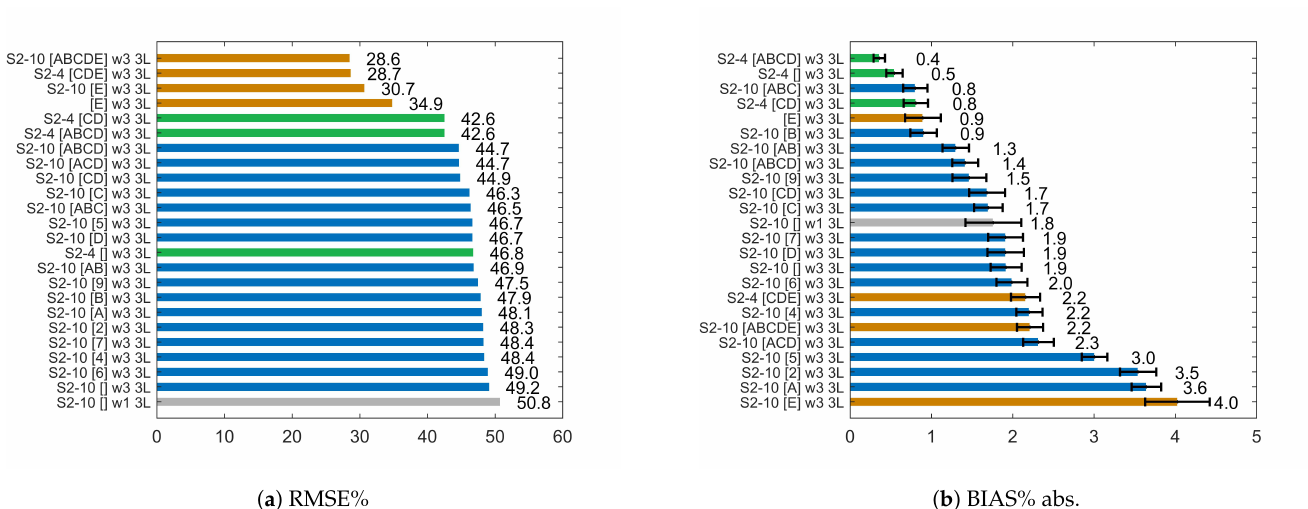
Figure 3. Test set relative root-mean-square error (RMSE%) and average of relative bias absolute values (BIAS% abs.) for DNN models predicting total stem volume with different input feature combinations. The results are mean values from 100 iterations of the modeling wrapper with the same hyper-parameter values. The bars are ordered with decreasing performance (the best performing on top). The bar colors correspond to the same feature combinations in both figures: gray = the baseline model; blue = models with all ten Sentinel-2 image channels ( S2-10 ) and various auxiliary features; green = models with four Sentinel-2 image channels ( S2-4 ); orange = models including CHM data (auxiliary input group E). The 99% confidence intervals are shown for BIAS% abs. only, as they are not distinguishable for RMSE% at this